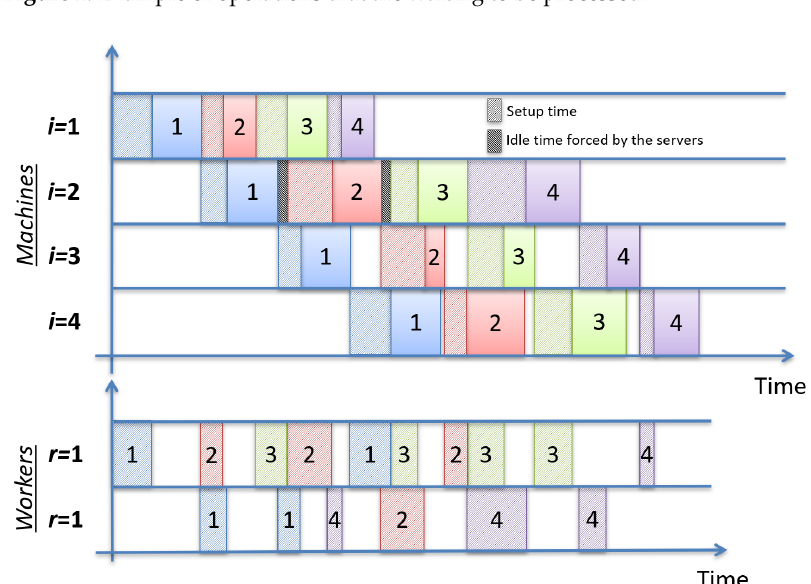
Figure 3. Example of using PR S